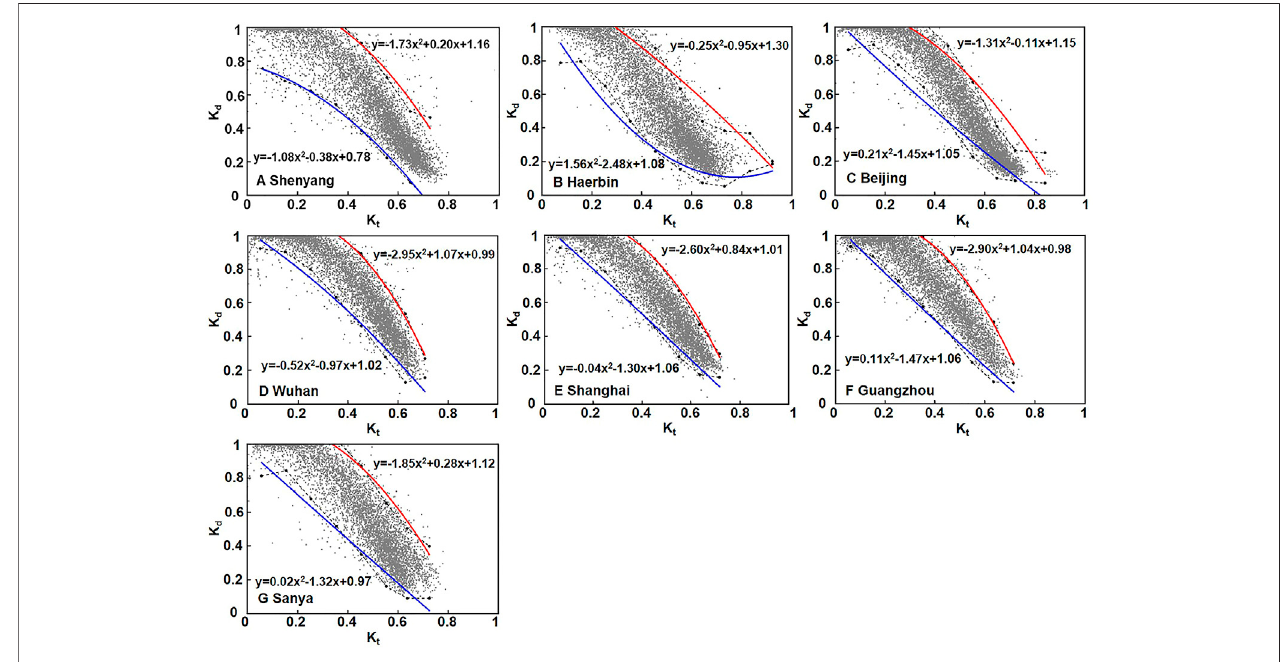
FIGURE 2 | The quality control chart of the diffuse radiation data of radiation